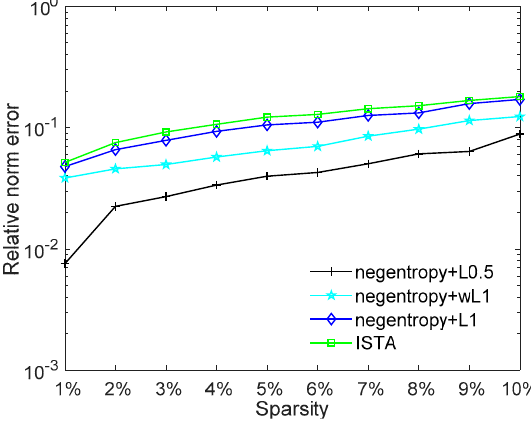
Figure 4. Relative norm error performance versus sparsity.